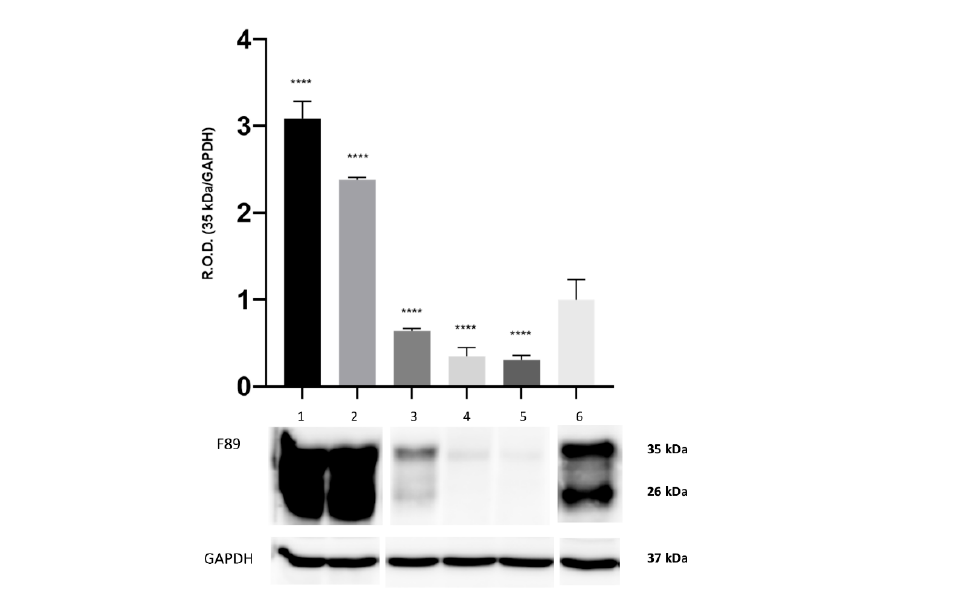
Figure 1. Representative Western blot (WB) analysis of the 35 kDa and 26 kDa bands obtained with the anti-prion protein (PrP) MAbF89/160.1.5. Brain tissue from three striped dolphin specimens found stranded along the Italian coast of Apulia (lanes 1 and 3) and in Canary Islands (lane 2), all of which affected by neurobrucellosis due to Brucella ceti . The results of WB analyses carried out on the brain tissue of one lamb (lane 4), one goat (lane 5), and one control ( B. ceti -negative) striped dolphin found stranded along the Tyrrhenian coast of Tuscany (lane 6) are also shown (original Western blot figure is in Figure S1). GAPDH was used as a protein load control. The graph depicts only the optical density of the 35 kDa band. The results are expressed as mean ± SEM ( n = 4). The statistical significance was analyzed by the ANOVA Dunnett method, **** p < 0.0001 vs. the striped dolphin negative control specimens.